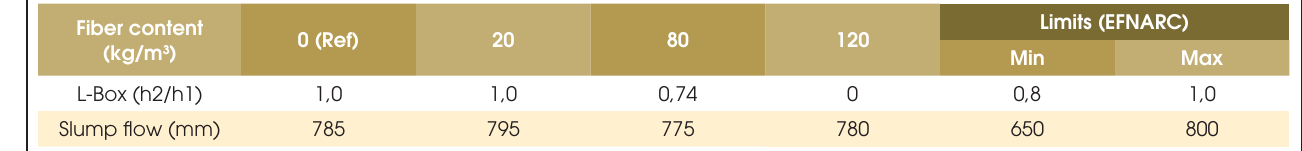
Table 3 – Results of the standard